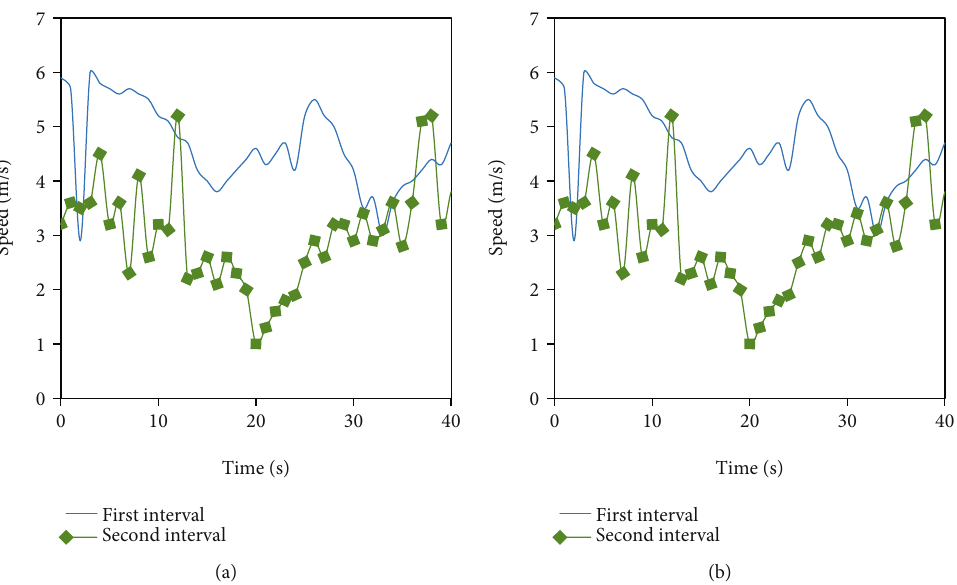
Figure 7: Median fi ltering e ff ect with a smoothing window size of